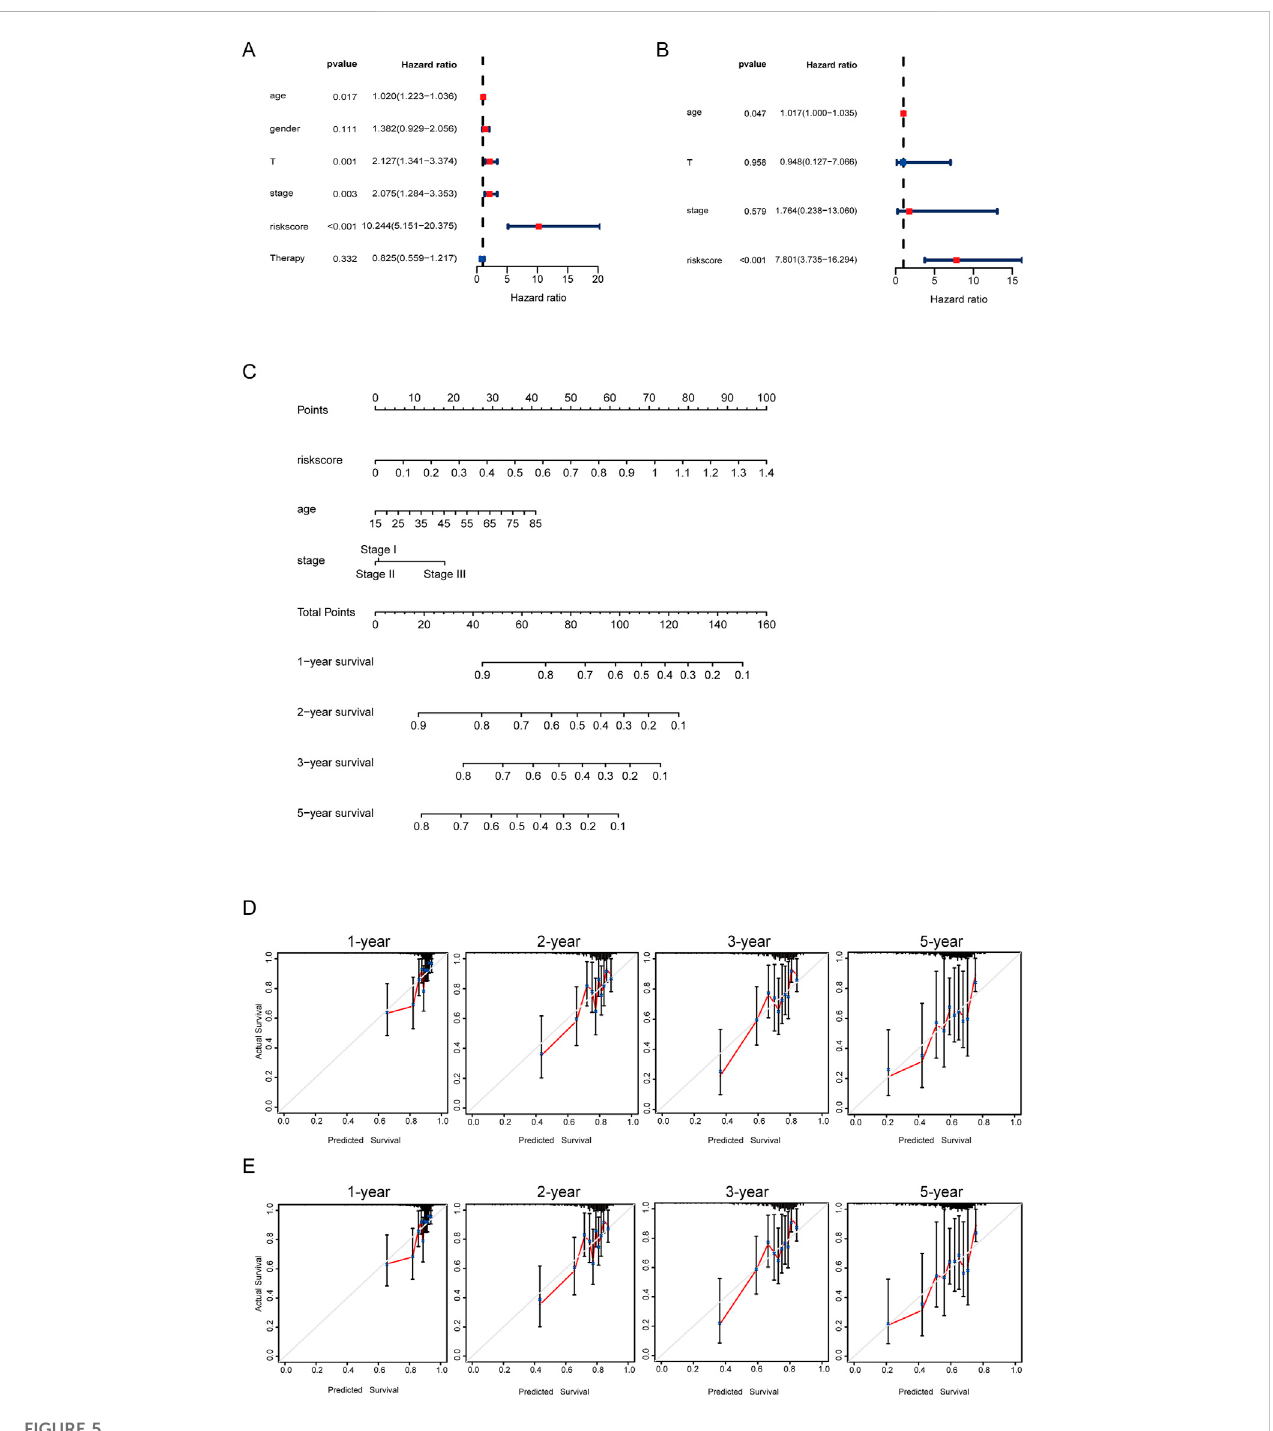
Developing a nomogram for predicting survival. (A) Univariate cox regression forest plot of risk score and clinical information. (B) Multivariate cox regressionforest plotofriskscore andclinicalinformation. (C) Nomogram fortheprediction oftheHCCpatients ’ survivalprobabilityat1,2,3,and 5 years. (D) Calibration curves of TCGA dataset. (E) Calibration curves of ICGC